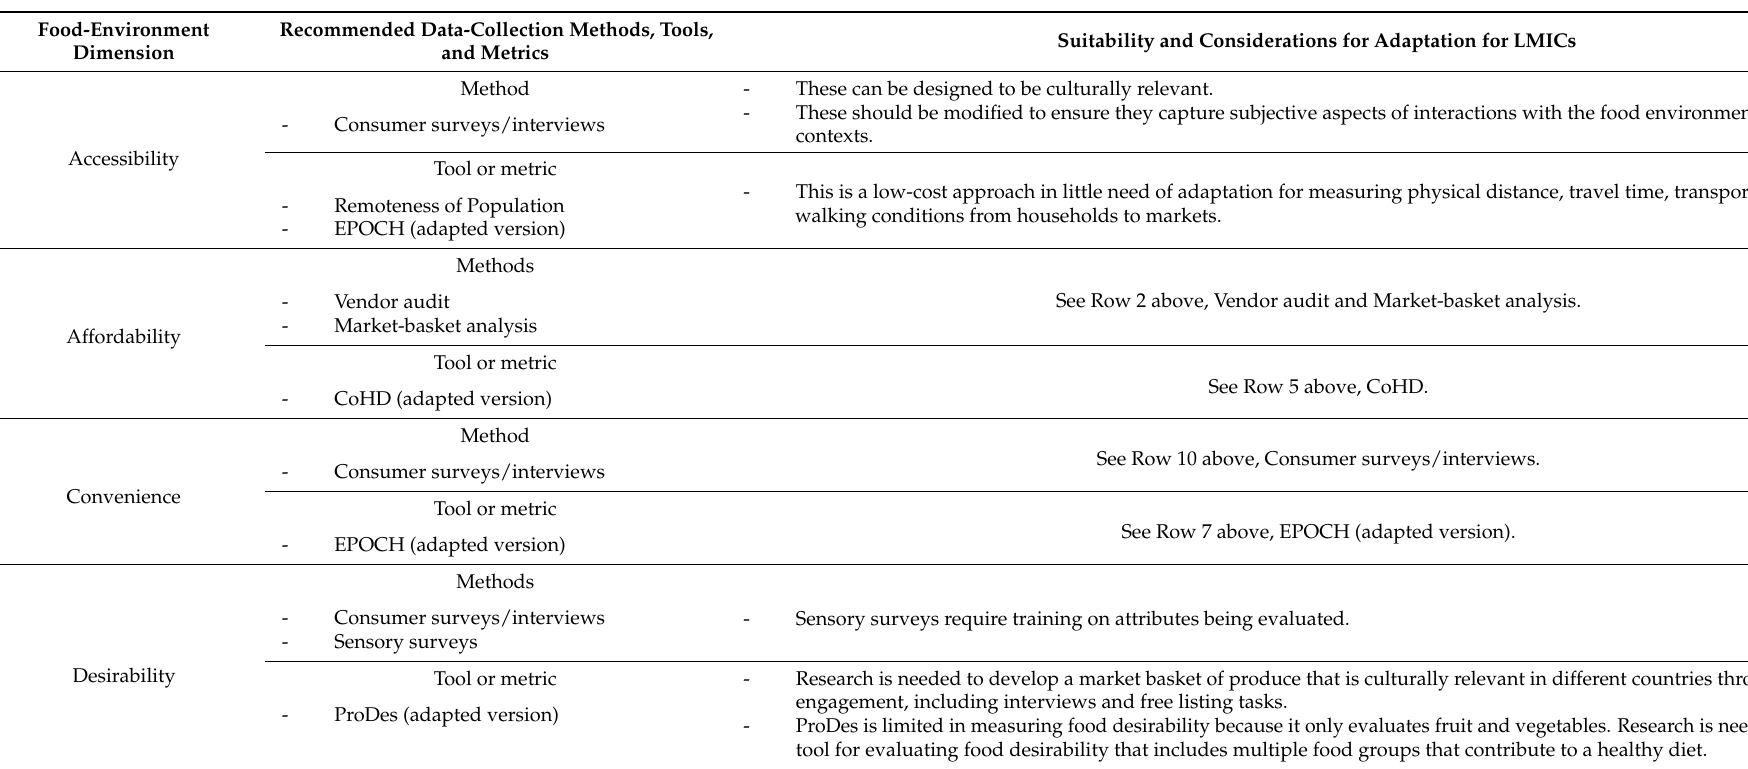
Suitability and Considerations for Adaptation for